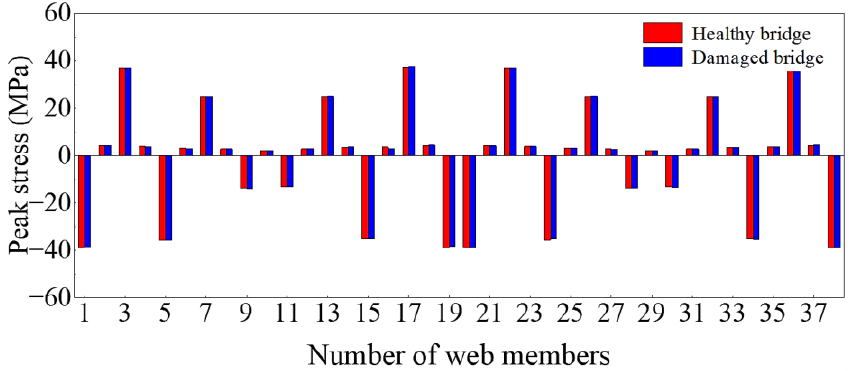
Figure 13. Stress inference results based on the vehicle loads without noise.